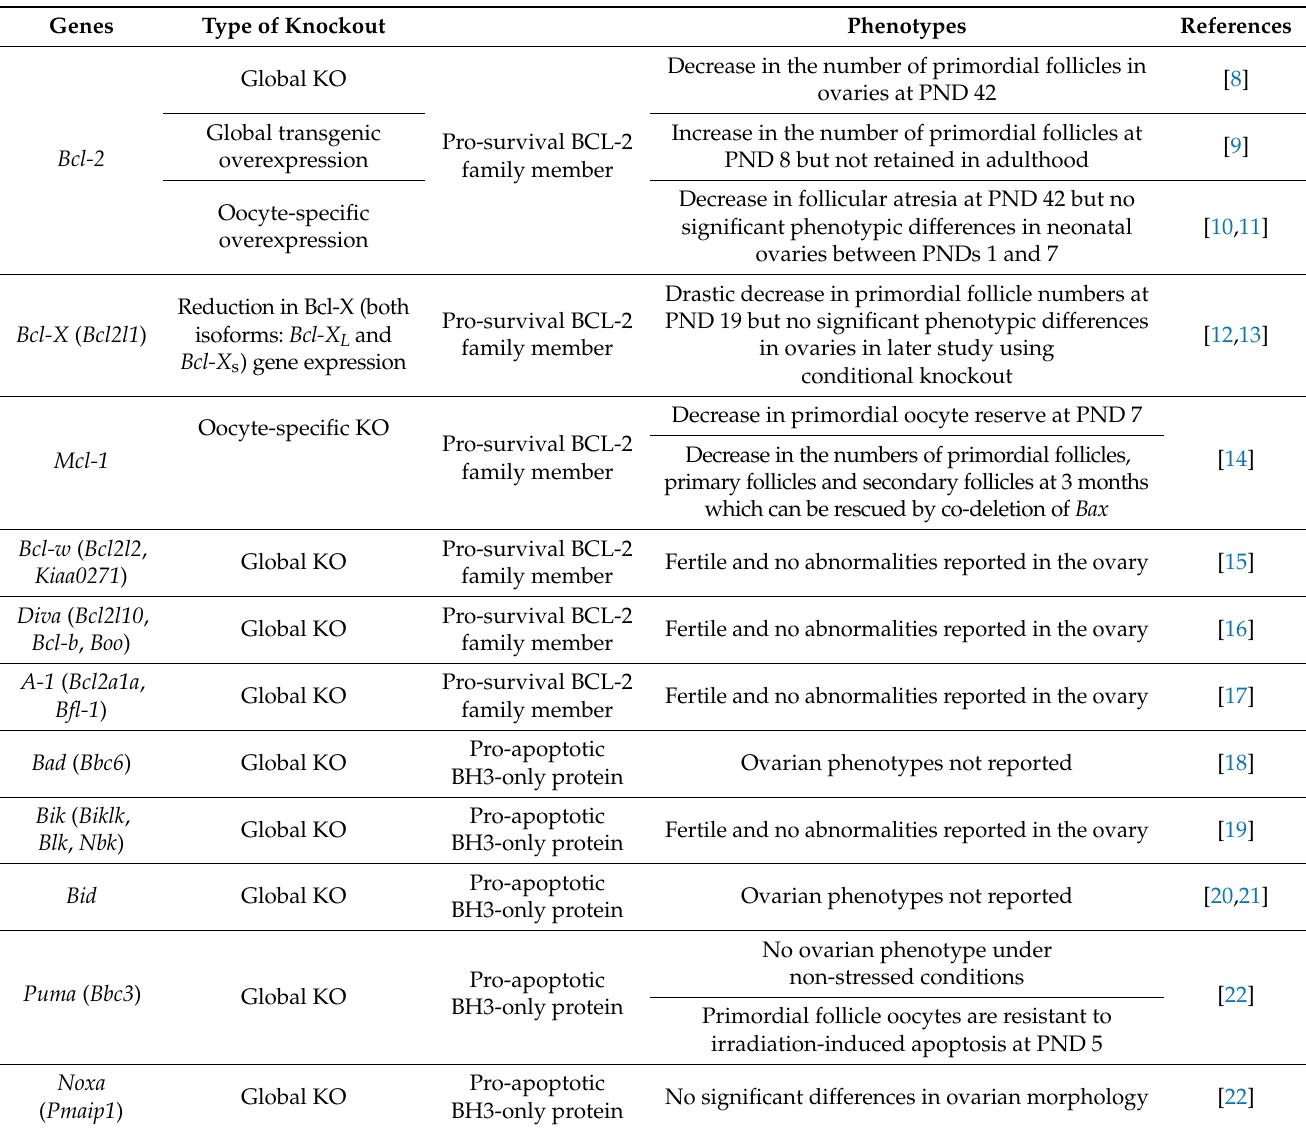
Table 1. Gene knockout mice related to the apoptosis